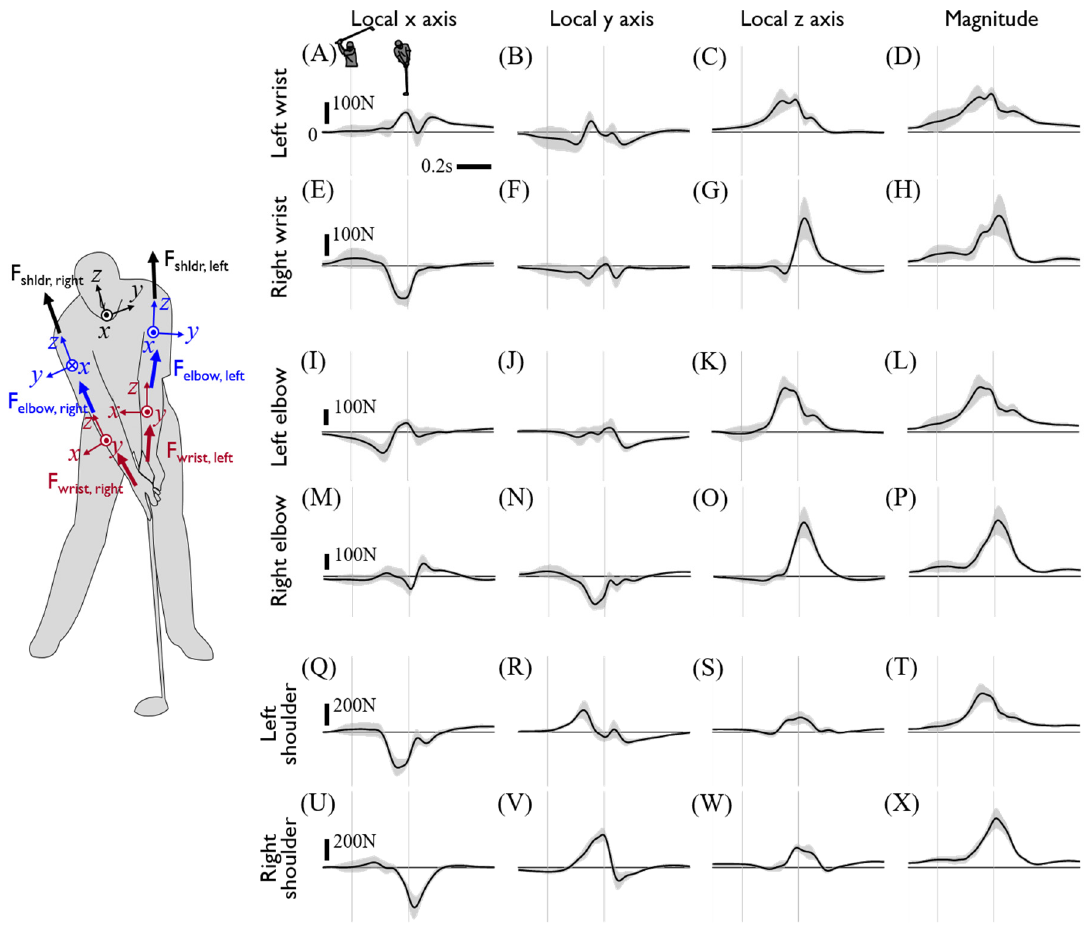
Figure 6. Calculated joint forces of the upper limbs. Each row shows the joint force of the left wrist ( A – D ), right wrist ( E – H ), left elbow ( I – L ), right elbow ( M – P ), left shoulder ( Q – T ), and right shoulder ( U – X ), respectively. Each column shows the x, y, and z values and the magnitude of joint force at the local coordinate of the proximal segment. The forces act on the distal segment of each joint and are averages of the driver swing data on all subjects. The two thin gray vertical lines indicate the backswing top and impact. The left silhouette shows the local coordinate of each segment at the address posture.